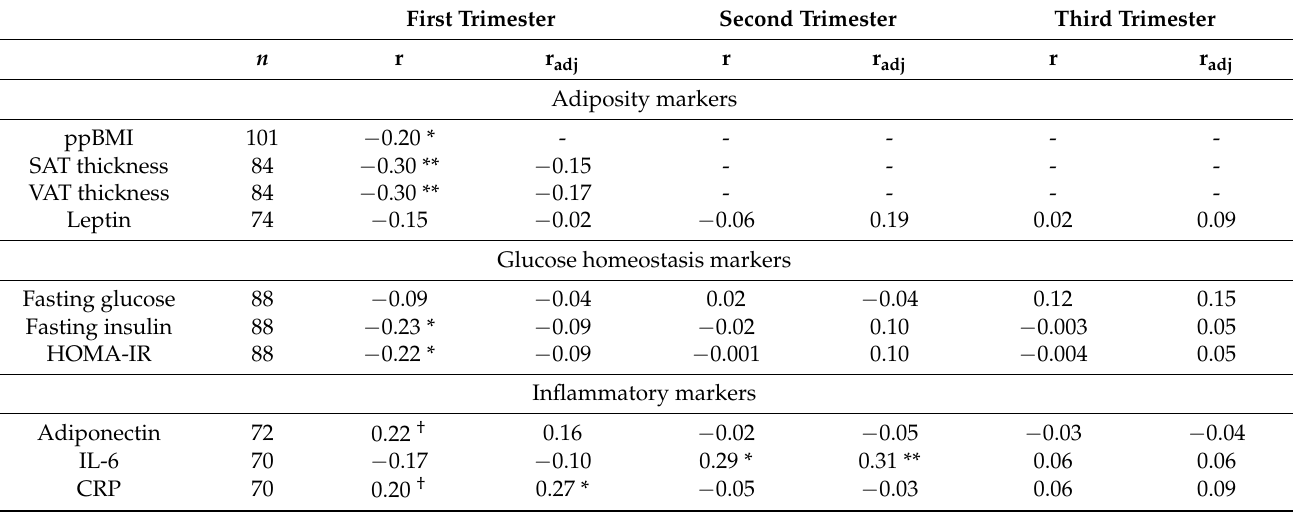
Table 3. Trimester-specific associations between albumin-corrected fructosamine and metabolic measurements.